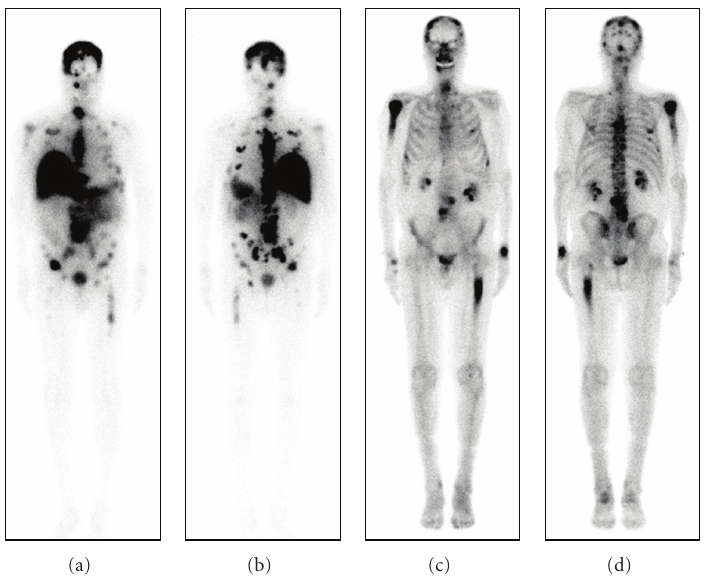
Figure 1: Anterior (a) and posterior (b) planar gamma camera images of radiolabeled J591. A greater number of lesions are apparent compared to anterior (c) and posterior (d) 99m Tc-MDP bone scan. Hepatic clearance of radiolabeled mAb results in nonspecific uptake in the